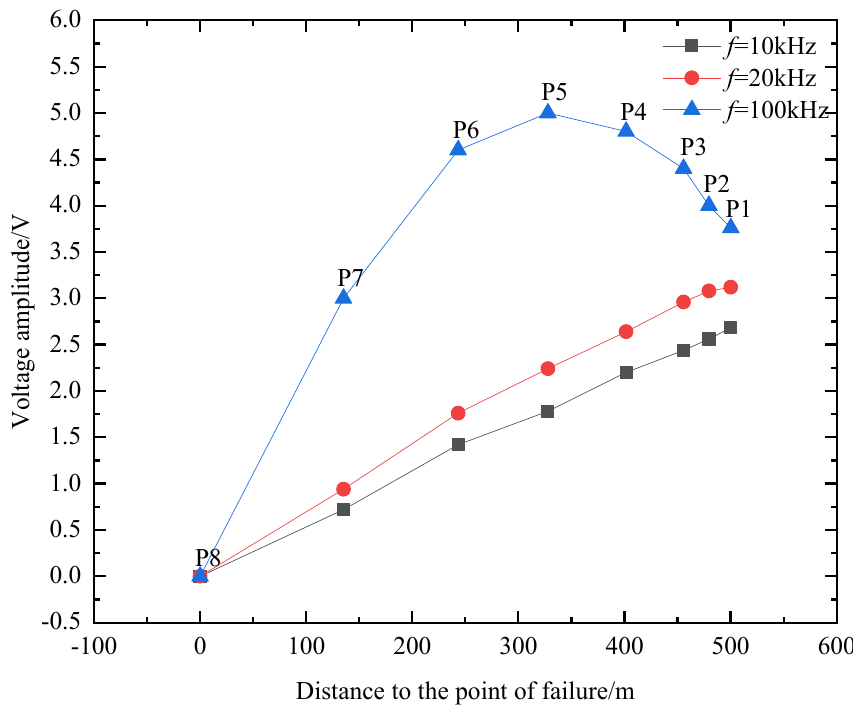
Figure 10. Actual data distribution at different frequencies of direct ground fault. When the frequency f is 10 kHz and 20 kHz, respectively, the voltage amplitude from the detection point P8 to the detection point P1 gradually increases; the two frequencies at this time both meet the restrictions in Formula (16), and the fault point can be accurately located through any two detection points. When the frequency f is equal to 100 kHz, from the detection point P8 to the detection point P1, it first increases and then decreases. This frequency is not monotonous and does not meet the restriction in Equation (16). At this frequency, any two detection points cannot be used to locate the fault point. The data at this frequency will not be processed during positioning, and they will only be reflected in the description of the standing wave phenomenon. The experimental results show that there is the same trend as the standing wave in the experiment. 5.4. Analysis of Single-Phase Direct Grounding Fault Location Results Through Formulas (14) and (19), the results obtained by bringing the experimental data into processing are shown in Table 5.